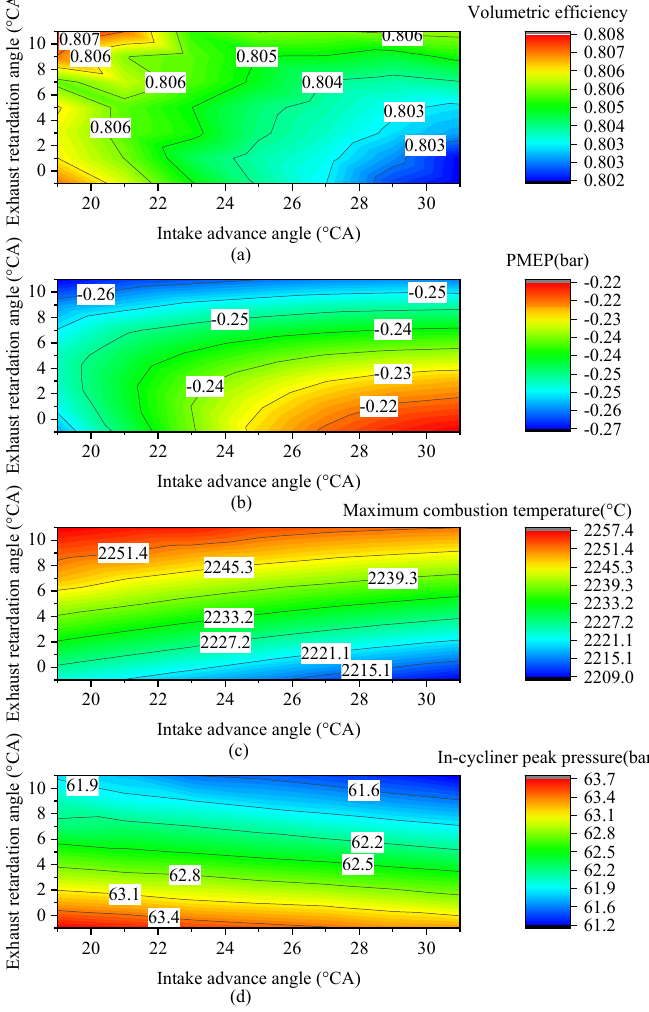
Figure 20. Volumetric efficiency, PMEP (Pumping Mean Effective Pressure), in-cylinder maximum combustion temperature and in-cylinder peak pressure versus the combined change of intake advance angle and exhaust retardation angle (point of operation: n = 3000 rpm, BMEP = 10 bar, CA50 = 8 °CA).